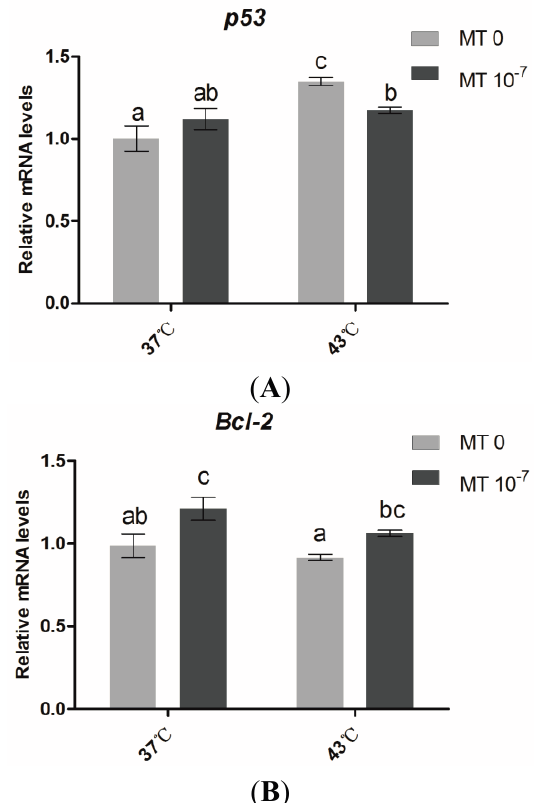
Figure 4. Effects of melatonin on the relative expression levels of p53 and Bcl-2 in sheep granulosa cells. ( A ) The relative expression of p53 at different treatments; ( B ) The relative expression of Bcl-2 at different treatments. MT: melatonin. Each bar represents the mean ± SEM for experiments performed in triplicate. Different letters in the same column represent significant differences, p <